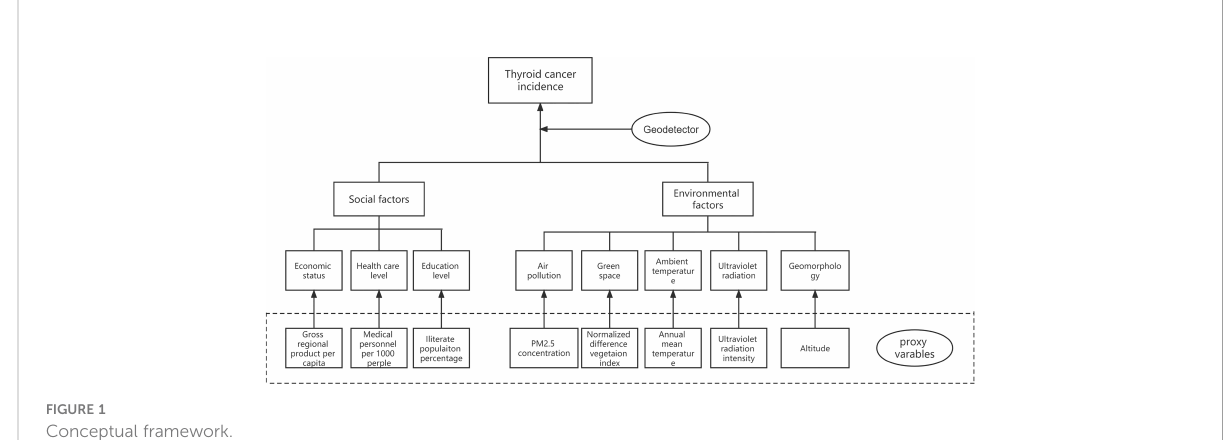
FIGURE 1 Conceptual